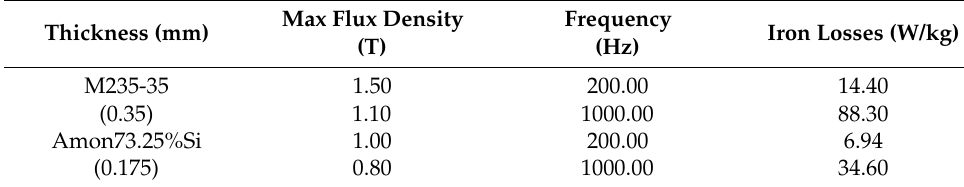
Table 3. Comparison of traditional and novel silicon steel material.